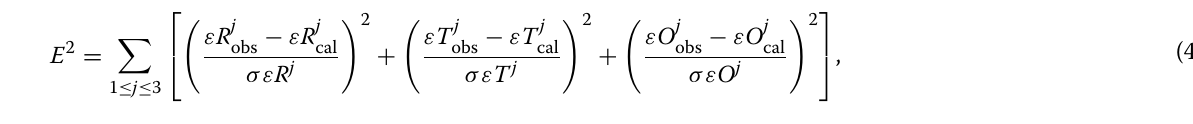
and where the subscripts obs and cal indicate observed i i and calculated values; δ R and δ T indicate the radial and tangential tilt change at the i -th tilt station, respec- j j j tively; ε R , ε T and ε O indicate the radial, tangential and oblique strain changes at the j -th observation tunnel, respectively; and σ indicates the observation error. The search spaces and step sizes for the parameter estimates are given in Table 1.